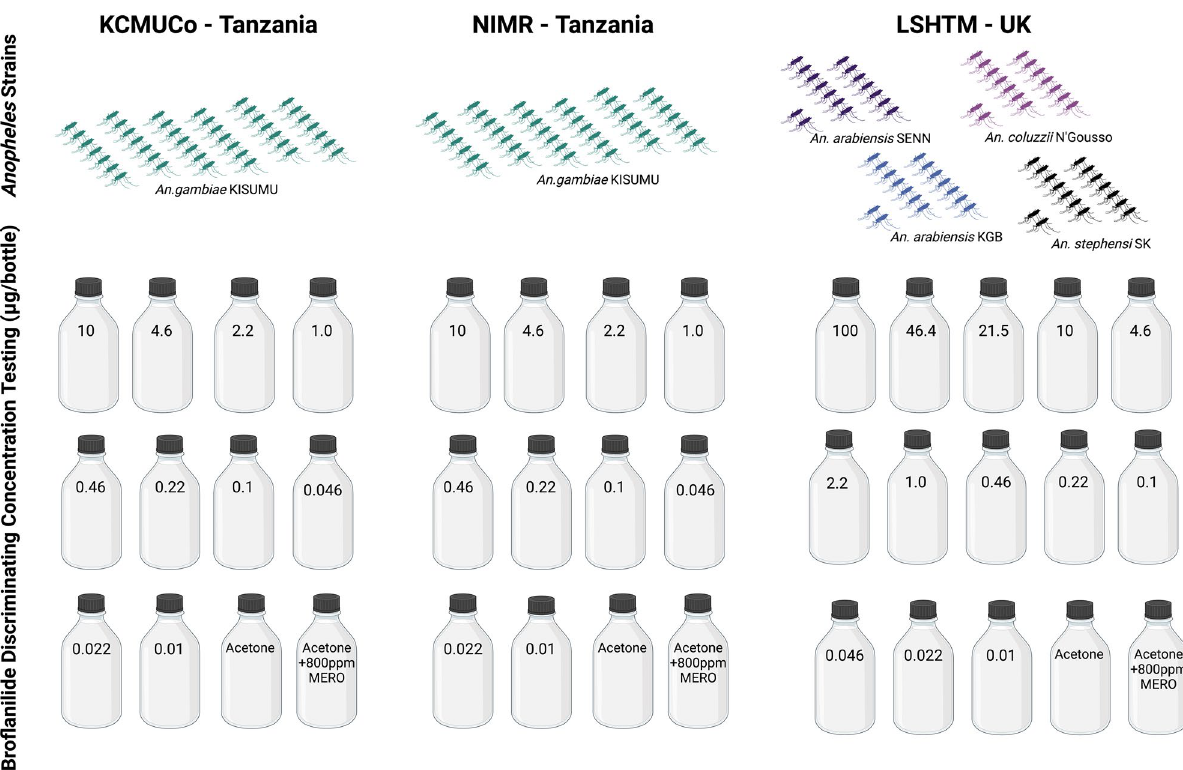
Figure 1. Multi-centre broflanilide discriminating concentration testing study: experimental design. Figure created using BioRender.com.